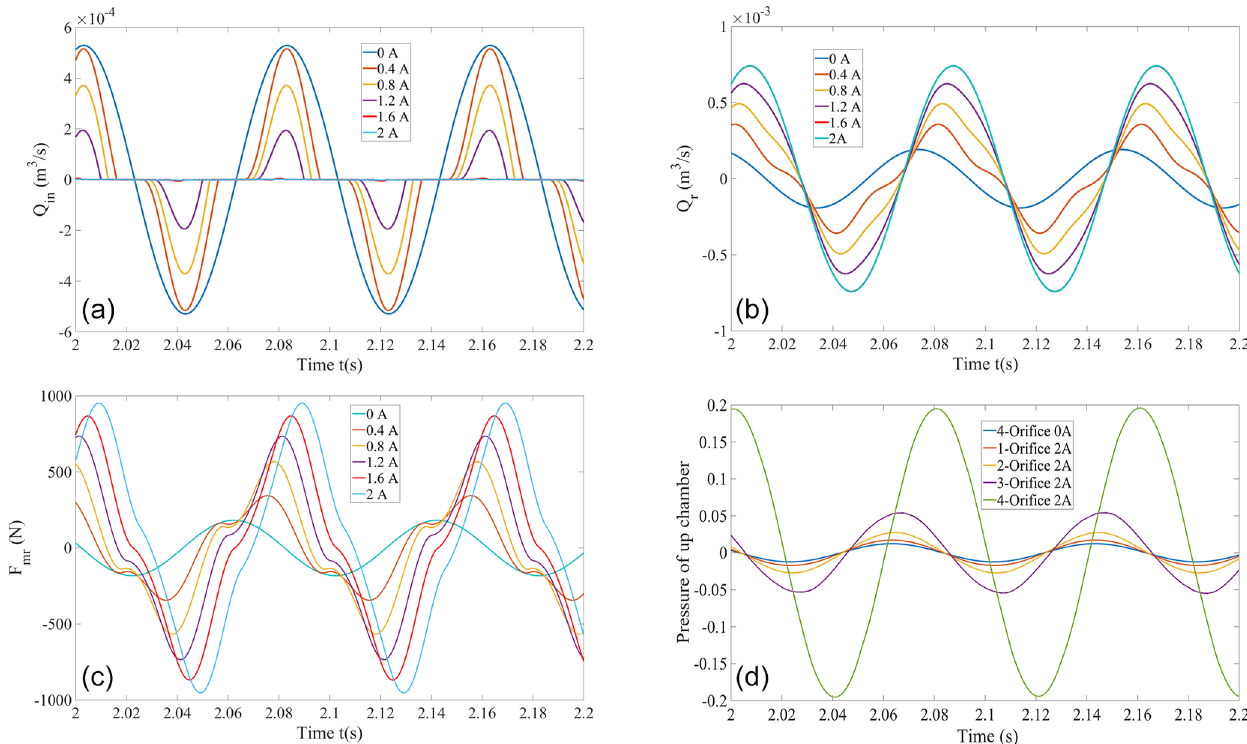
Figure 11. Controlled multi-channel magnetorheological fluid mount flow, damping force, upper chamber pressure, (a) single controlled channel flow rate; (b) rate-dip flow rate; (c) single controlled channel damping force and (d) upper chamber pressure.